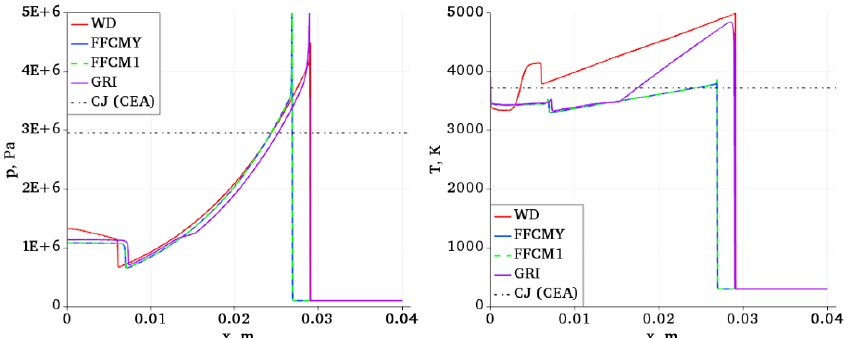
Figure 4. One dimensional detonation tube pressure and temperature at 0.01 mm WD, GRI 3.0, FFCMy-12 and FFCM-1 [31].